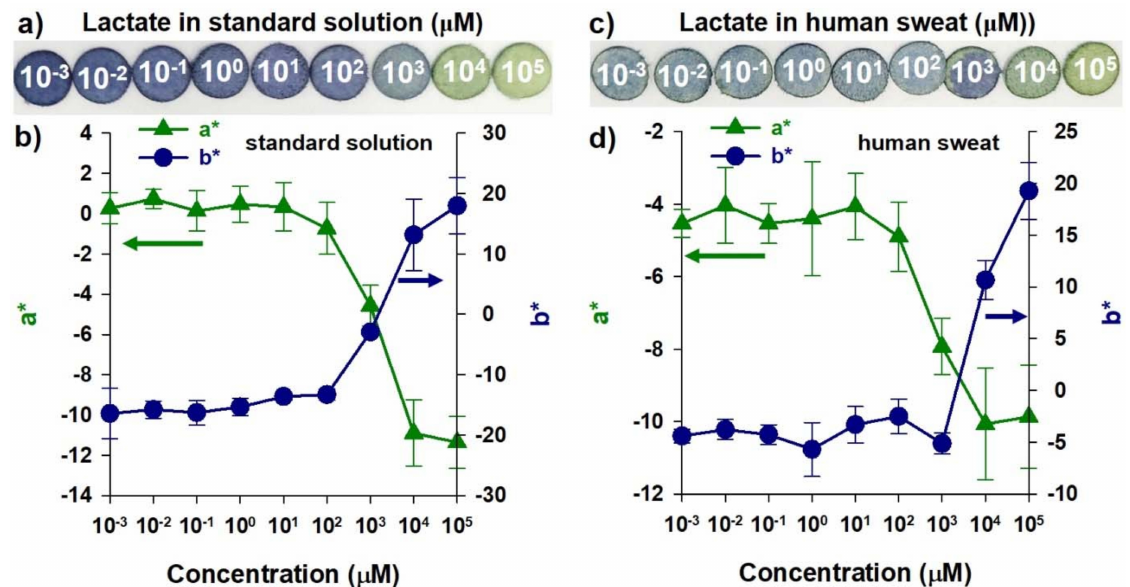
Figure 5. ( a ) Photograph and ( b ) a* and b* values of each TPAni paper sensor platform according to lactate concentration using standard solutions ( n = 10). ( c ) A photograph and ( d ) a* and b* values of each TPAni paper sensor platform using various lactate concentrations in human sweat ( n =